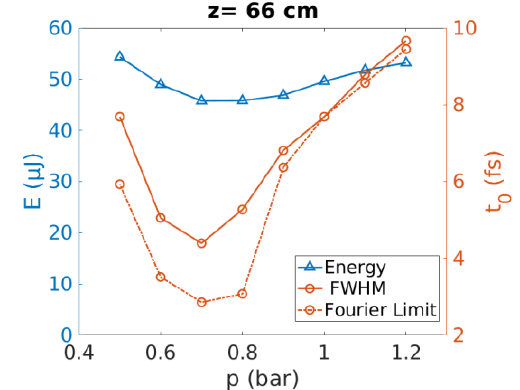
Fig. 2. Evolution of the temporal intensity (top row) and spectral intensity (bottom row, in log scale) distributions at a point of maximum intensity. The white line represents the ZDW at 679 nm.